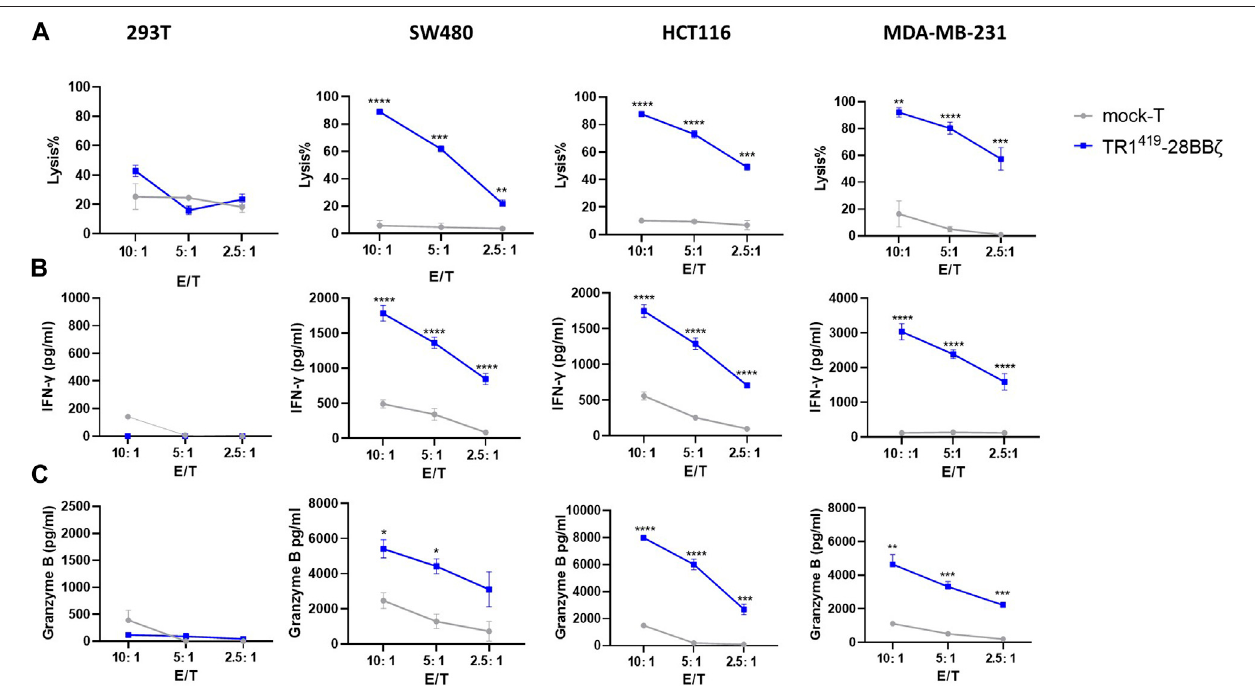
FIGURE2| TR1 419 -28BB ζ CAR-Tcellsinducedsigni fi cantcytolysisofTRAIL-R1 – expressingtumorcells. (A) CytotoxicactivityofTR1 419 -28BB ζ CAR – transduced T cells or mock T cells against TRAIL-R1 – positive tumor cell lines was determined by calcein AM release – based assay. The effector cells were cocultured for 6 h with targetcellsatE:Tratioof10:1,5:1,and2.5:1,respectively.IFN- γ (B) andgranzymeB (C) productionbyTR1 419 -28BB ζ CAR-TcellsormockTcellswhencoculturedwith the indicated cells for 24 h was deducted by ELISA. Data are given in the mean ± SEM of three separate experiments. * p < 0.05, ** p < 0.01, and *** p <